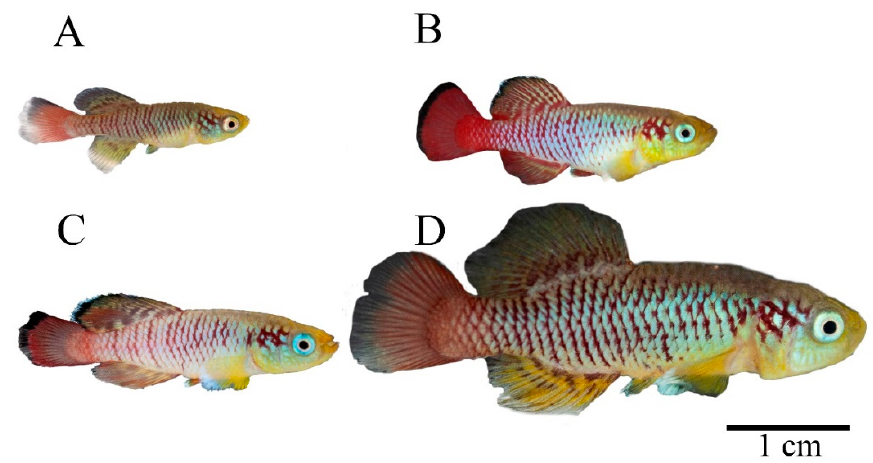
Figure 1. Morphological changes in the coloration of male N. guentheri, depending on hierarchical status and age. ( A ) Young male with signs of primary coloration (1.5 months); ( B ) Young male of high hierarchical status (4.5 months); ( C ) Adult male (6 months); ( D ) Adult male with signs of coloration regression (8 months).